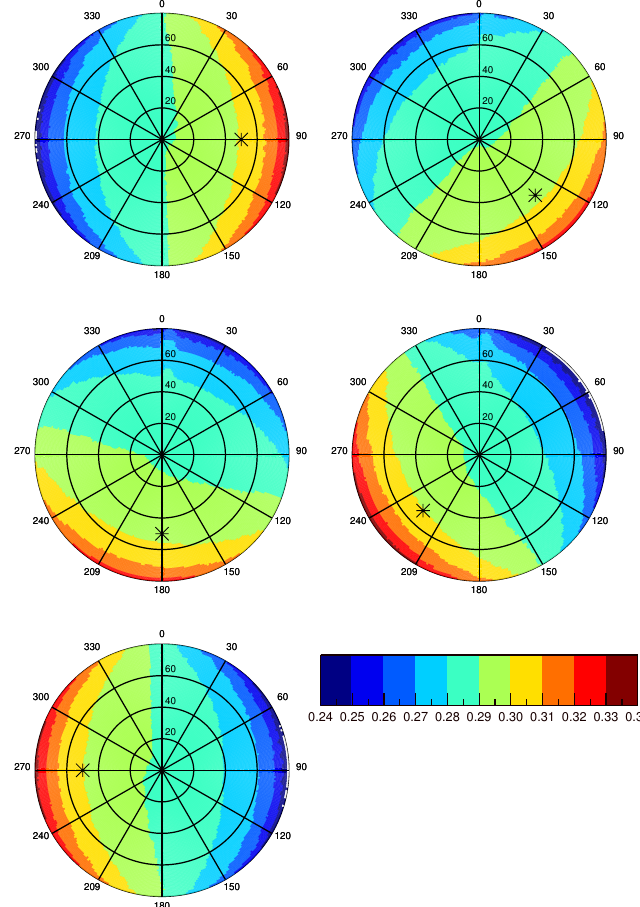
Figure 7. Polar plots of Raytran surface BRF simulations over Libya-4 for the 20 × 20 km ROI and SZA = 50 ◦ . Sand reflectance is equal to 0.3. Circles represent zenith angles, and polar angles represent azimuth angles with a zero degree azimuth pointing to the north. The ∗ symbol indicates the Sun position.